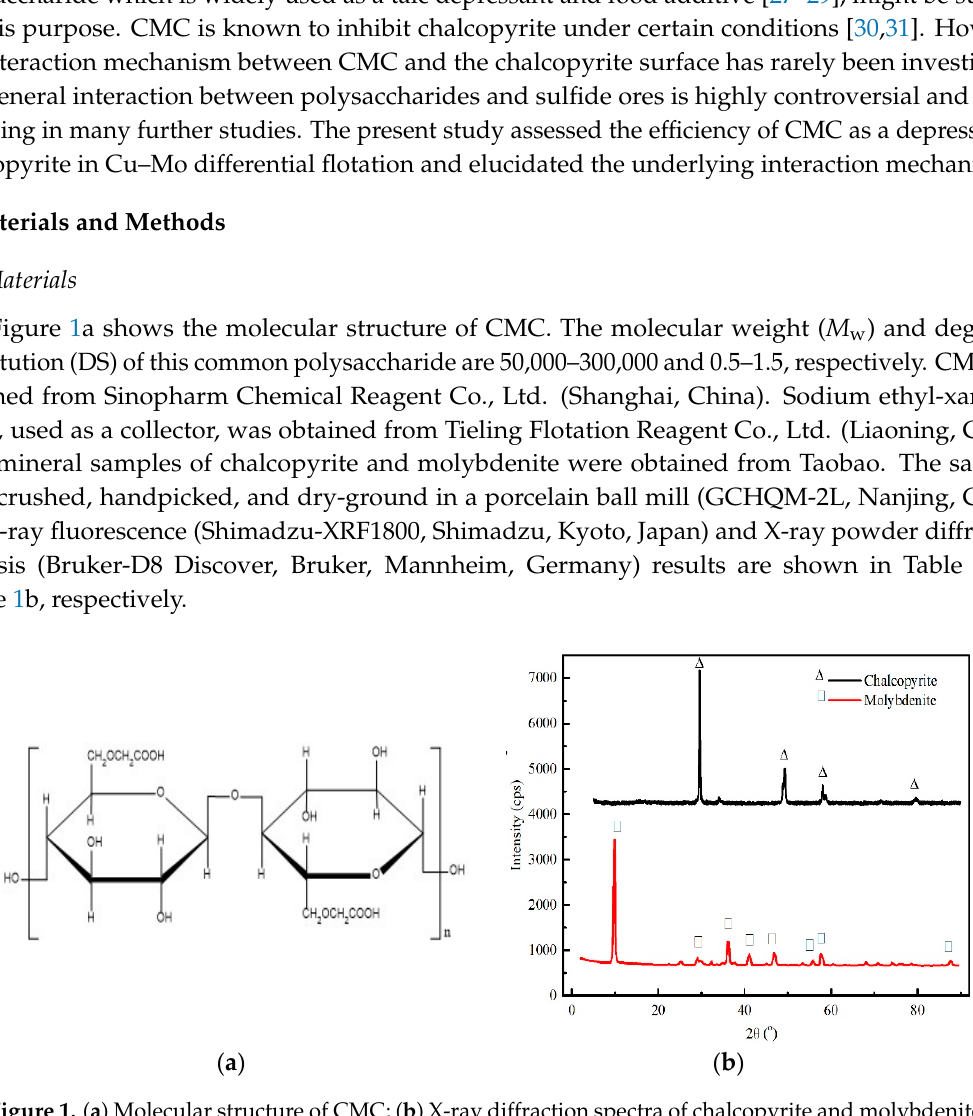
Figure 1. ( a ) Molecular structure of CMC; ( b ) X-ray diffraction spectra of chalcopyrite and molybdenite. Table 1. X-ray fluorescence results of chalcopyrite and molybdenite (mass fraction, %). Element